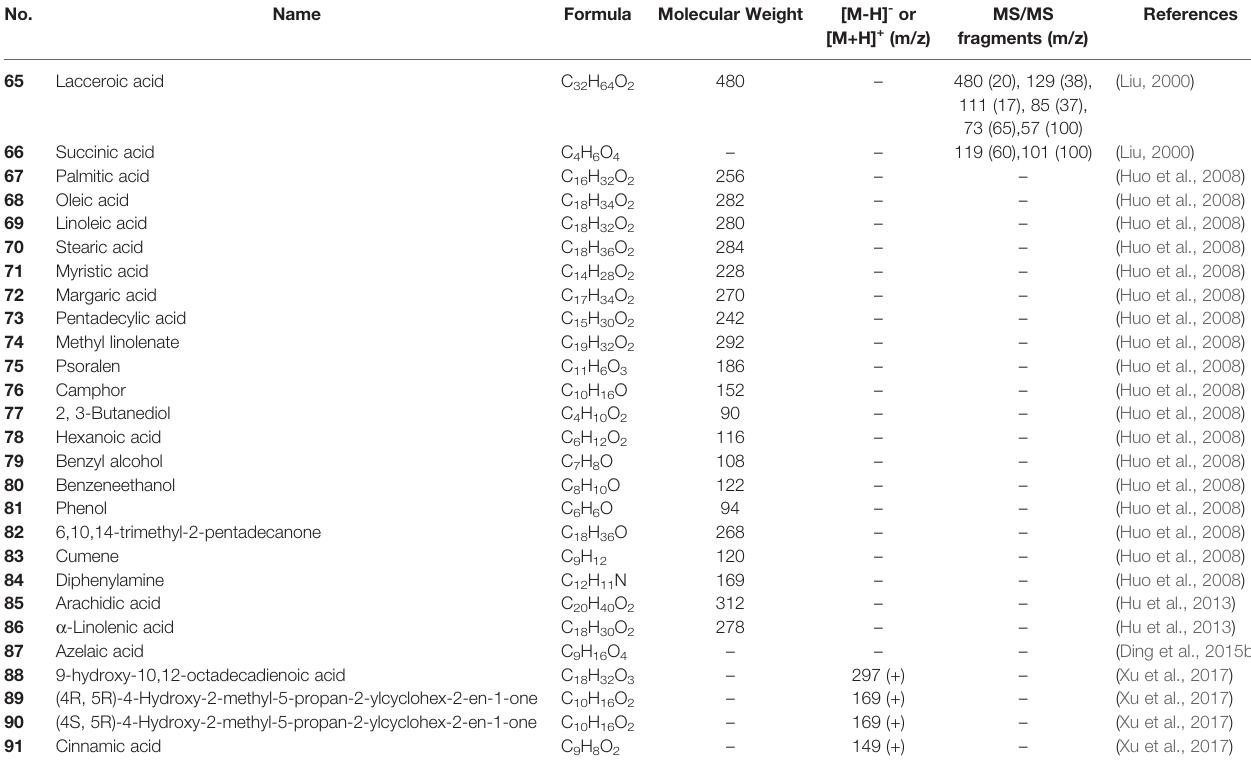
TABLE 4 | Volatile oil and fatty acids from Tetrastigma hemsleyanum Diels &